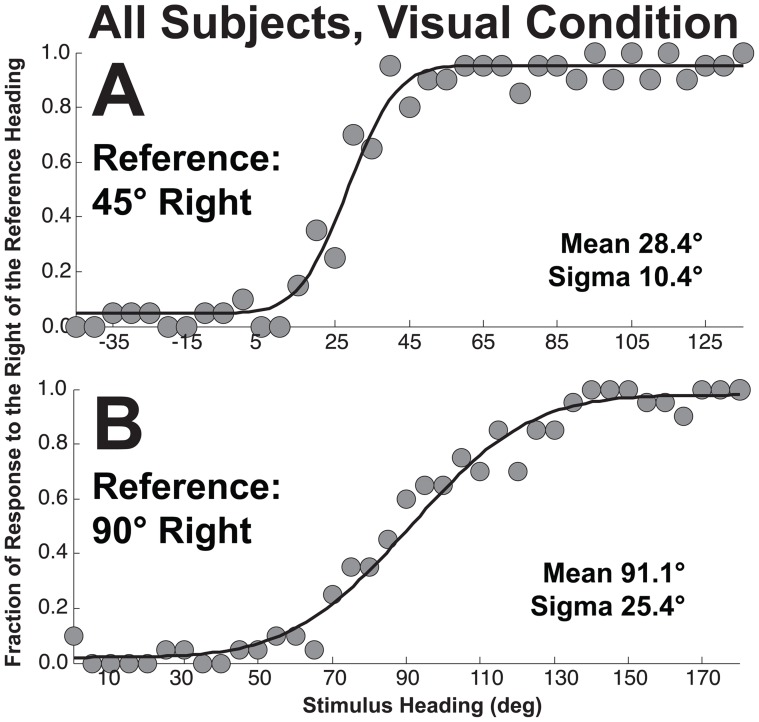
The psychometric method of determining perceived heading for two sample headings.The plot contains data from all 10 subjects each of whom completed 2 blocks of trials with the visual stimulus. Thus, each data point represents 20 stimulus presentations. For each plot a reference heading was chosen and stimulus headings at ±90° relative to the reference heading were considered. The ordinate represents the fraction of responses to the right of the reference heading. With ideal performance, all the headings to the left of the reference stimulus heading would be 0 and all the headings to the right of the reference would be one. The solid line represents the cumulative distribution function which best approximates the data. Panel A: Reference heading is 45° right. The cumulative distribution function predicts that the point of subjective equality (PSE) at which the stimulus is equally likely to be perceived left or right of 45° would be 28.4°. Panel B: The reference heading is 90° right. In this example a perceived heading of 90° is most likely with a stimulus of 91.1°. Although the accuracy of the perceived heading is better, the precision (sigma) is worse when compared with 45° in panel A.